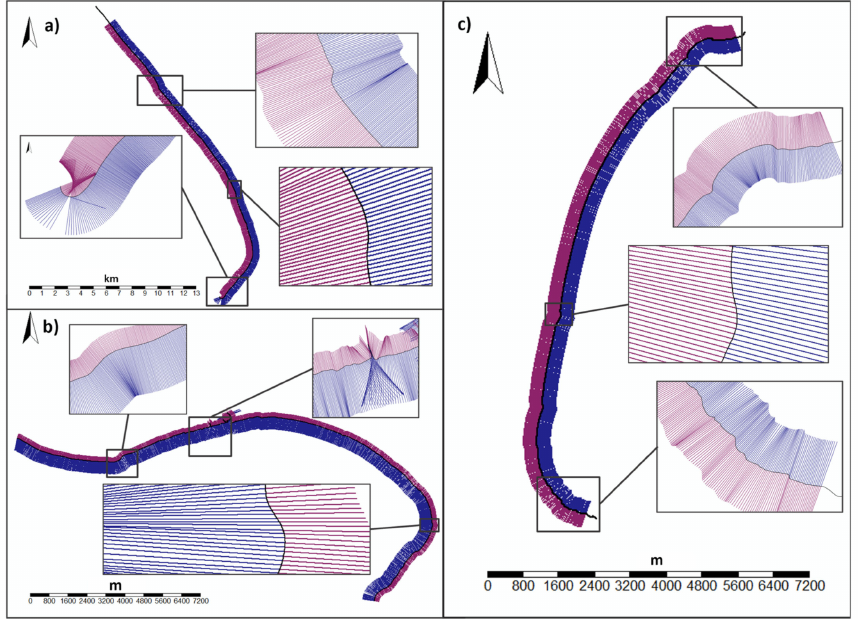
Figure 7. Baseline (black) and landward (maroon) and seaward (blue) transects at ( a ) Site #1, ( b ) Site #2 and ( c ) Site